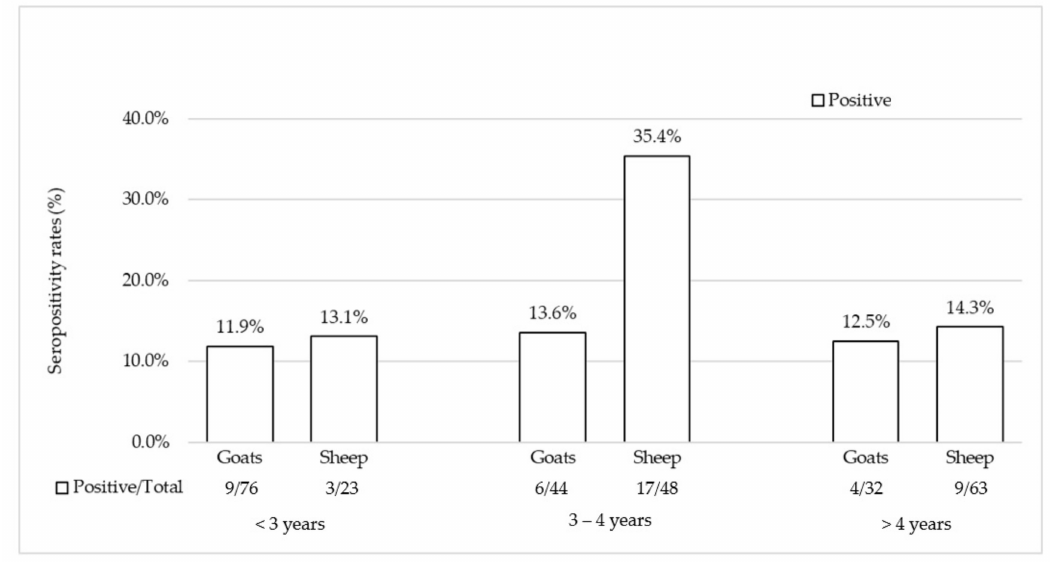
Figure 3. Antibodies to HEV in goat and sheep sera of di ff erent age groups.